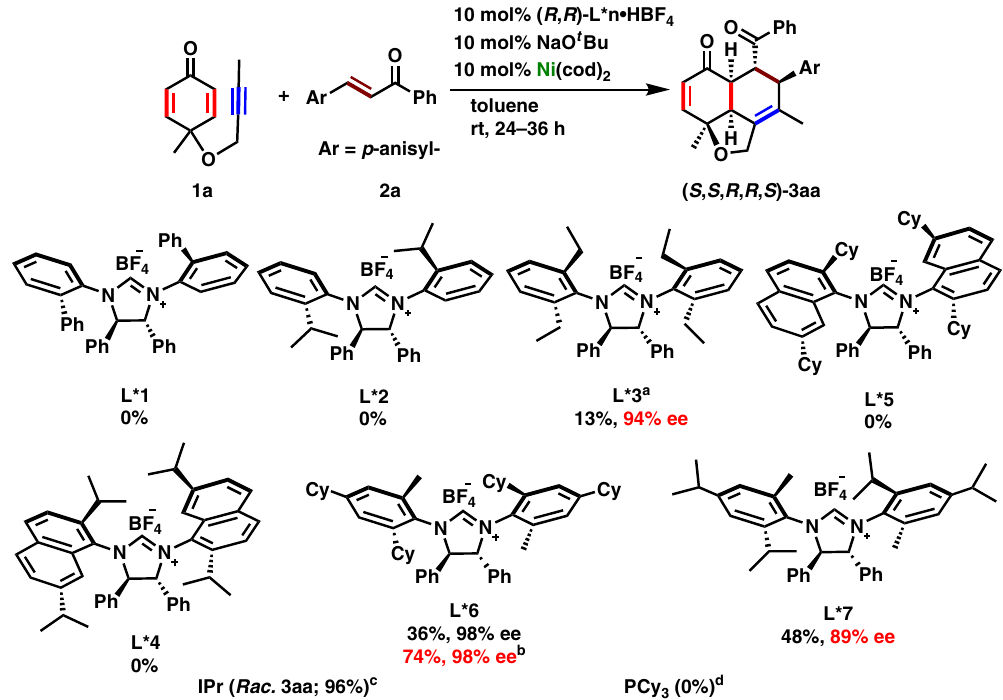
Fig. 2 Evaluation of Ligands. ( R , R )- L*n · HBF 4 , NaO t Bu, Ni(cod) 2 (0.01 mmol each), 1a (0.12 mmol), 2a (0.10 mmol), and toluene (1.0 ml) are employed. Isolated yields are given and enantioselectivity was determined by SFC equipped with a chiral stationary phase. a Yield and enantioselectivity was measured at 27% conversion in 3 days. b 5 ml toluene was employed and reaction was conducted at 60 °C. c 10 mol% IPr was used instead of chiral NHC salt and NaO t Bu. d 20 mol% PCy 3 was used instead of chiral NHC salt and NaO t